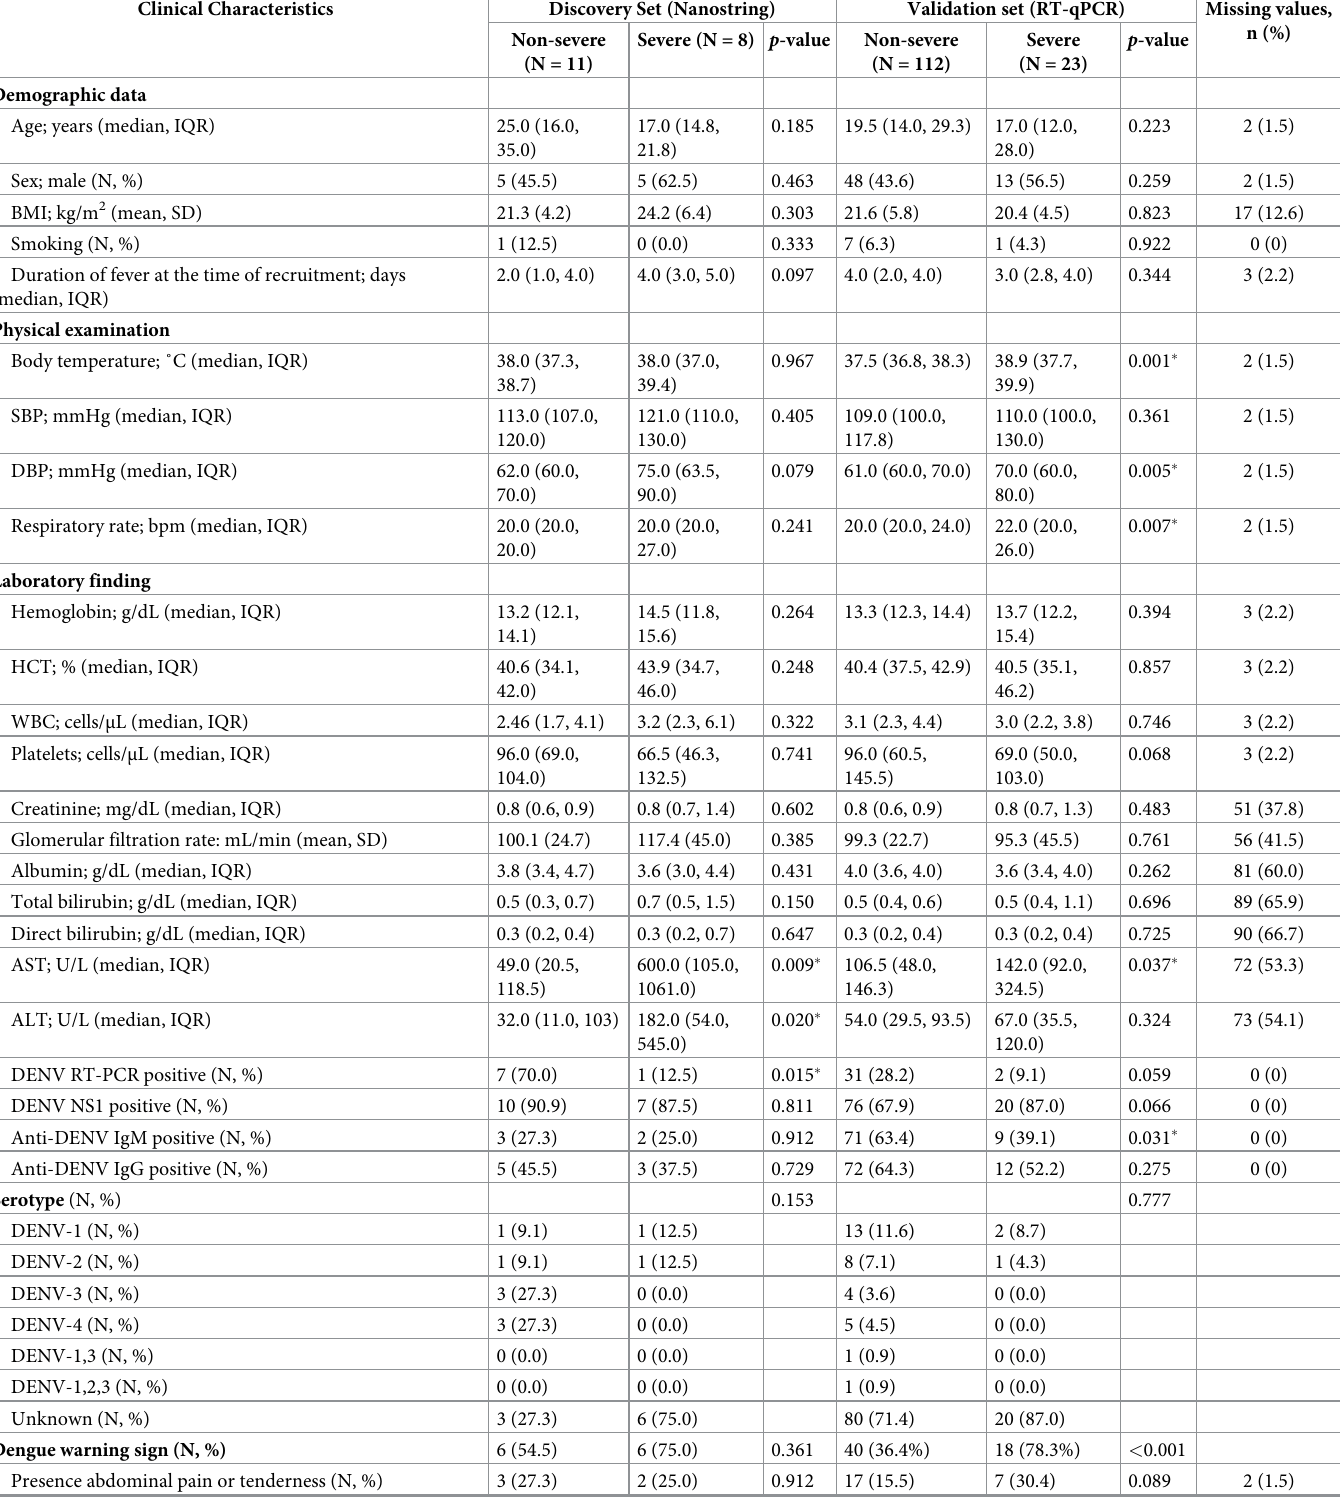
Table 1. Patient characteristics at